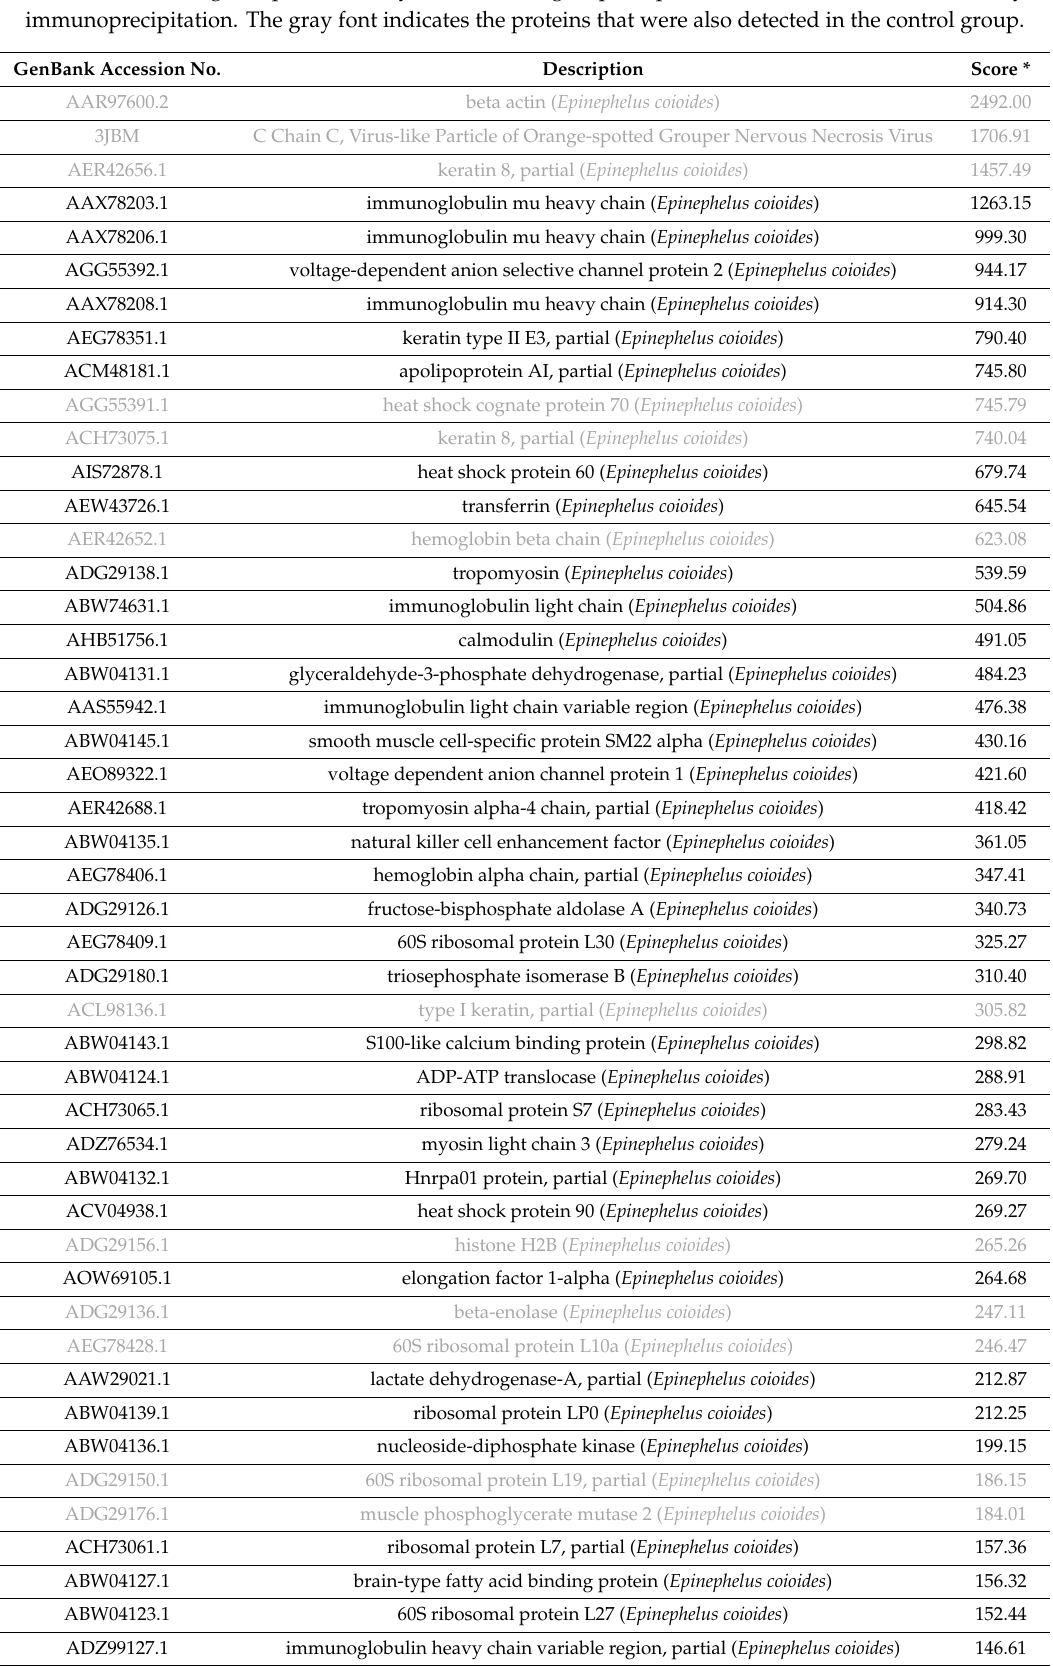
Table 2. The original protein assay data in the grouper optic nerve with native NNVCP by immunoprecipitation. The gray font indicates the proteins that were also detected in the control group. GenBank Accession